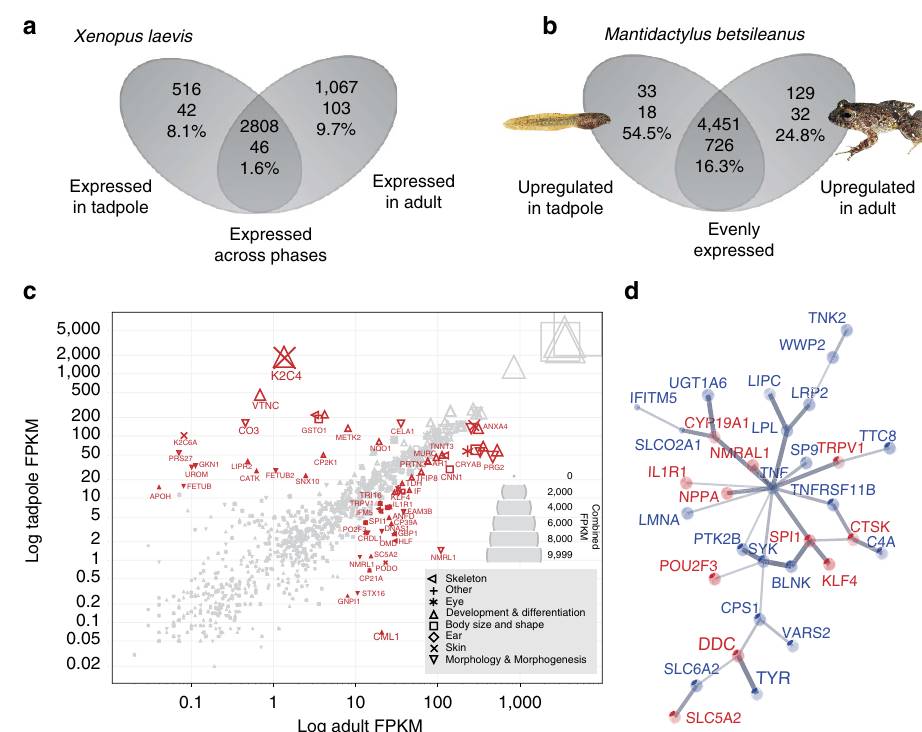
Figure 2 | Life-history specific gene expression and contribution to phenotype in frogs. ( a , b ) Venn diagram showing summary statistics of genes differentially expressed between life-history phases tadpole and adult, and combinations of these in ( a ) Xenopus laevis (from Xenbase) and ( b ) Mantidactylus betsileanus (from two newly sequenced transcriptomes). Numbers in Venn diagrams: top row, number of annotated genes expressed per phase; middle row, number of genes associated with morphological feature formation expressed per phase; bottom row, percentage of morphological- feature-formation-associated genes. ( c ) Morphology-associated gene expression in adult and tadpole M. betsileanus shown as scatterplot of log tadpole FPKM (fragments per kilobase of exon per million reads mapped) versus log adult FPKM. Symbols denote different categories of morphology-associated gene ontology terms; if one gene has more than one term the symbols are partly overlapping. Symbol size represents combined adult and tadpole FPKM value, as shown in the stacked FPKM scale (right). Red labelled symbols denote significantly differentially expressed transcripts (protein symbols). ( d ) STRING subnetwork (confidence view) of functional interactions between some genes expressed in adult life phase in Xenopus (blue gene symbols) and M. betsileanus (red gene symbols). Expressed genes of both species are linked within the same functional network with ‘osteoclast differentiation’ as the significantly overexpressed function. Line thickness represents strength of confidence for interactions. Table 1 | Selection of models for species diversification of mantellid frogs